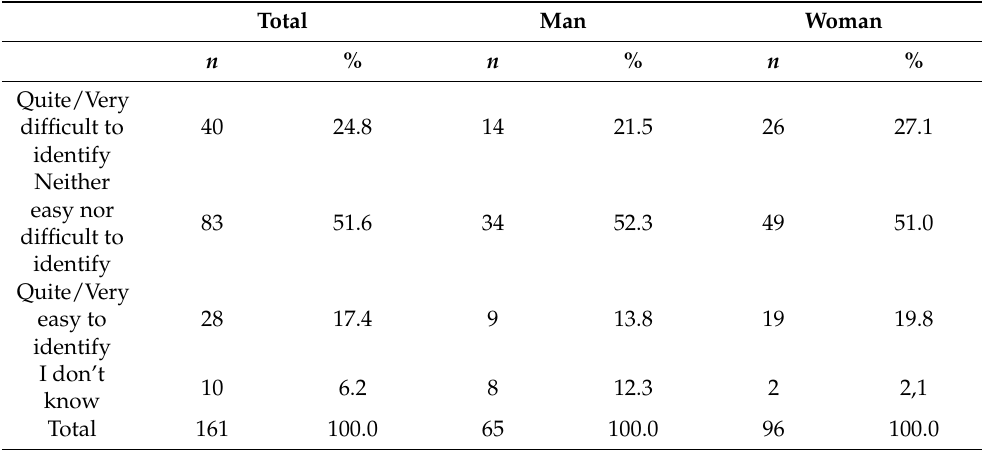
Table 6. Identification of healthy